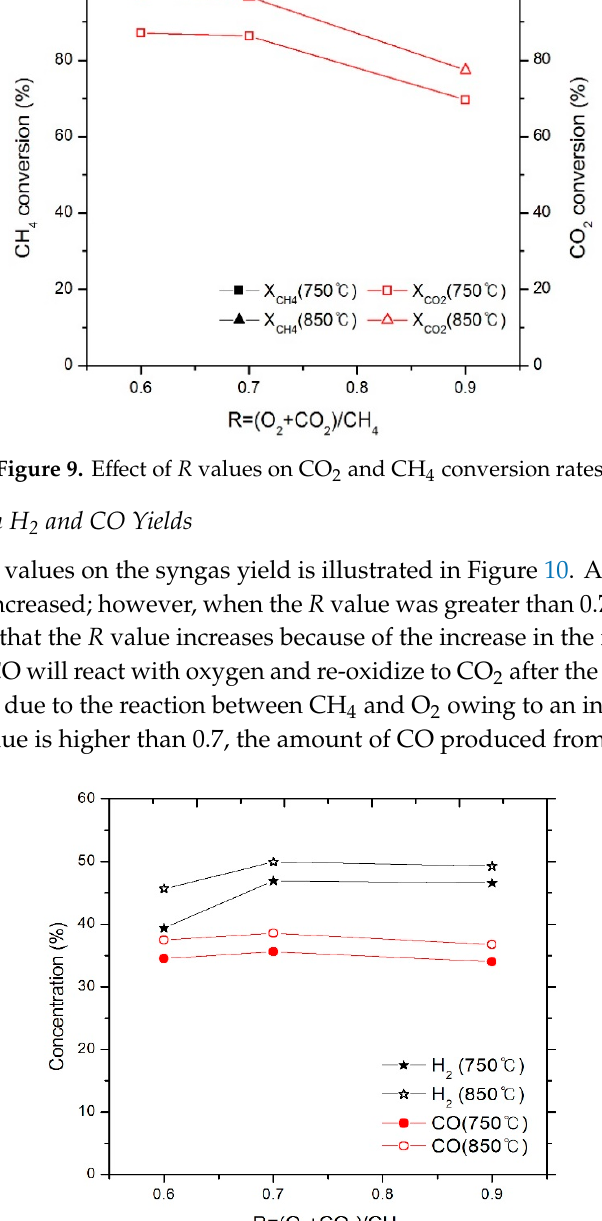
Figure 9. Effect of R values on CO2 and CH4 conversion rates.